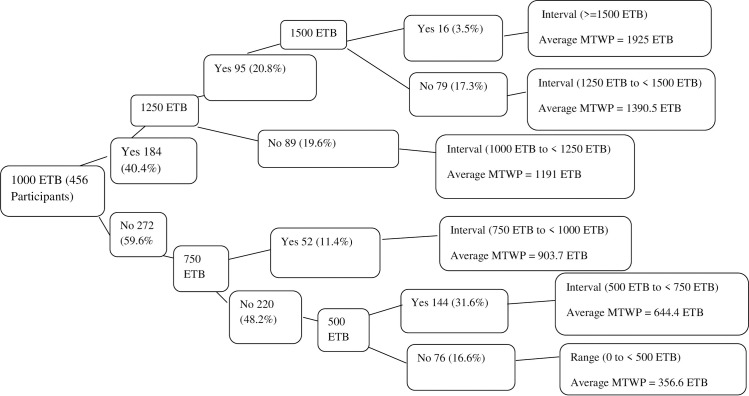
Iterative bidding technique to elicit willingness to pay for cataract surgery in outreach Sites, North West Ethiopia.First bidding questions: If the cost of cataract surgery for one eye is ETB 1000, are you willing to pay that amount? December 2018 Exchange rate: US$ 1 = ETB 27.8.